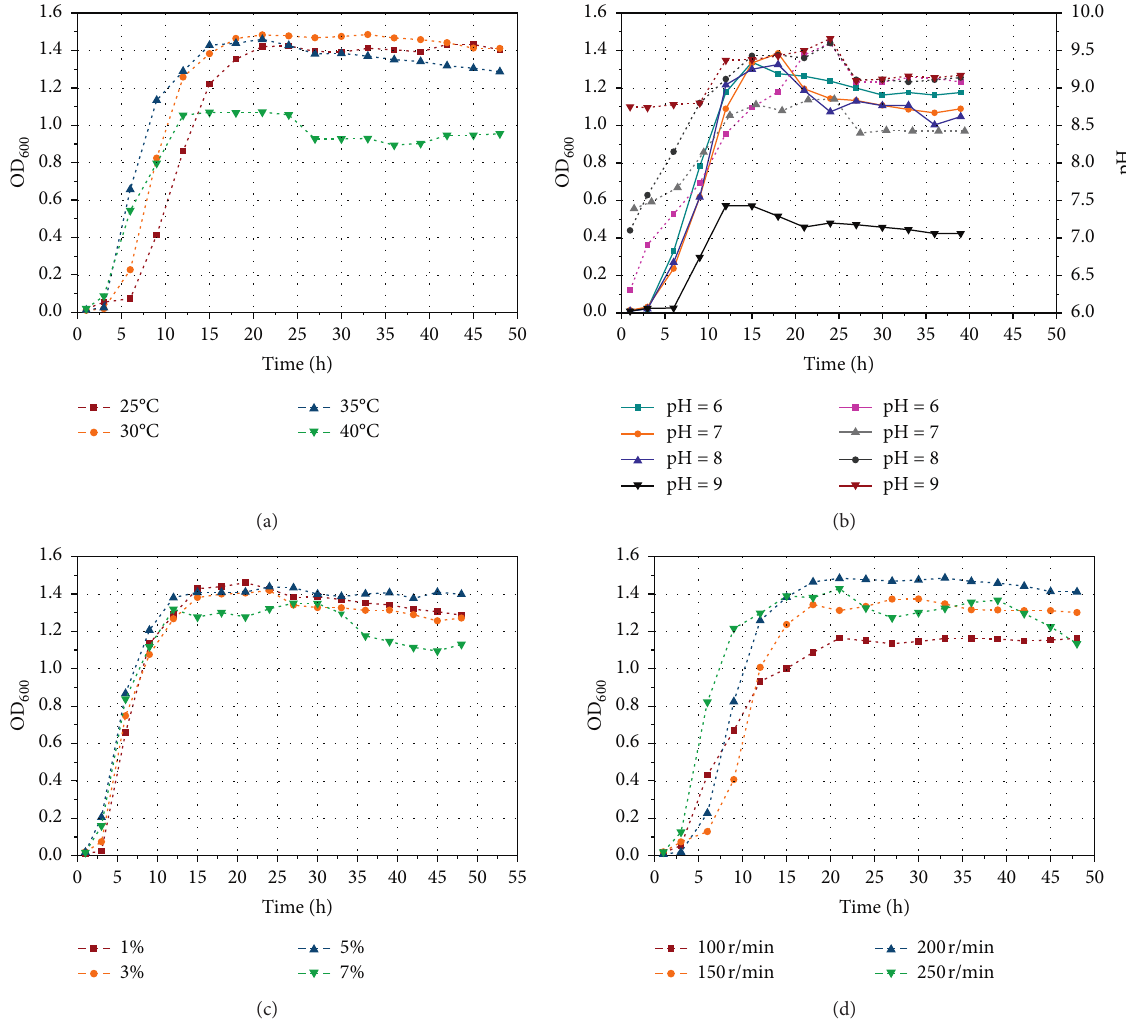
Figure 7: (a) The effect of temperature on bacterial growth; (b) the effect of pH on bacterial growth; (c) the effect of bacterial inoculation volume on bacterial growth; (d) the effect of shaker speed on bacterial